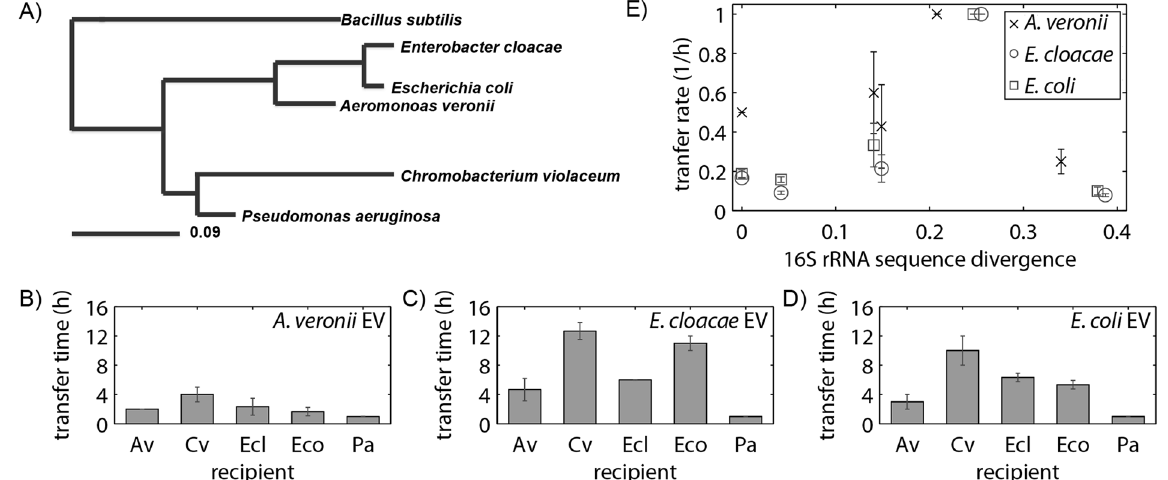
Figure 4. Donor and recipient species influence rates of vesicle mediated gene transfer. ( A ) Relatedness of recipient species based on 16S rRNA sequence. Donor EVs packed with pLC291 from donor strains A . veronii ( B ), E . cloacae ( C ) and E . coli ( D ) were added to recipients strains A . veronii , C . violaceum , E . cloacae , E . coli , and P . aeruginosa . The time to plasmid transfer was measured by selective plating as in Fig. 2. ( E ) The transfer rate was not correlated with the relatedness of the donor and recipient strains, as measured by divergence of the 16S rRNA sequence. Error bars signify standard deviation from 4